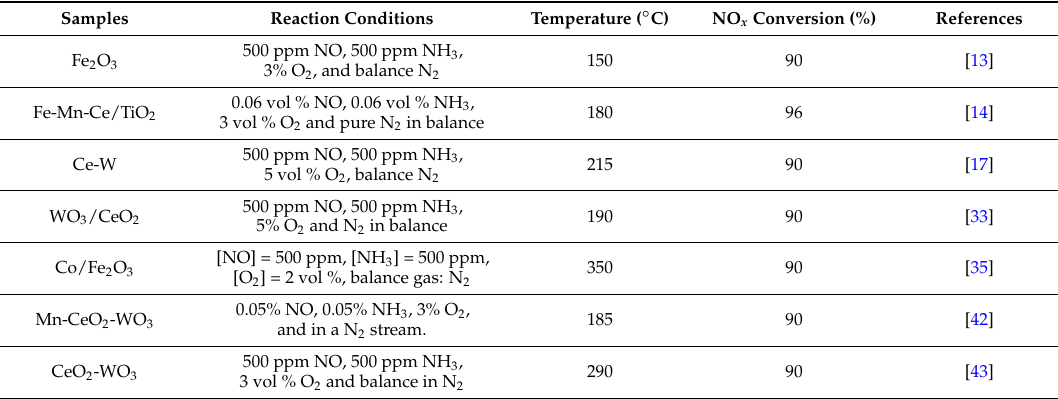
Table 2. Comparison of the activity for NH 3 -SCR on different